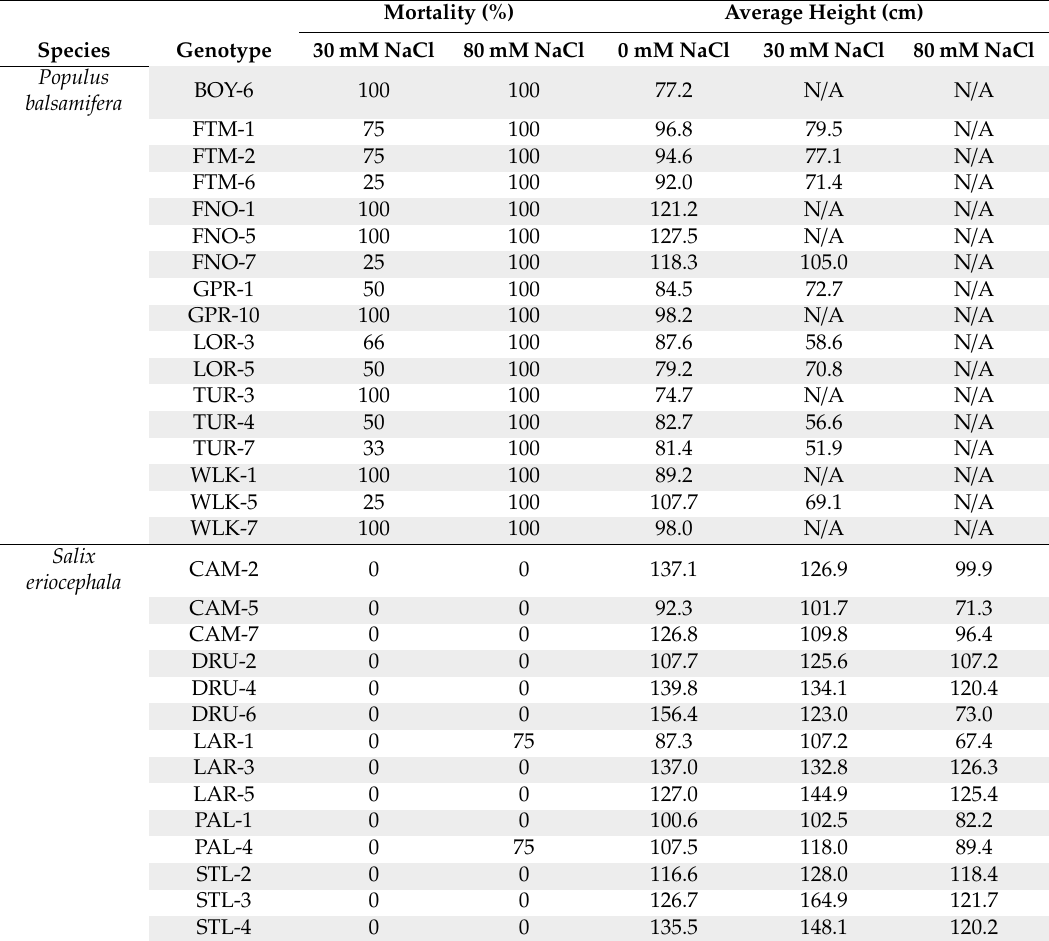
Table A4. Mortality and average height of 32 poplar and willow genotypes from screening trial